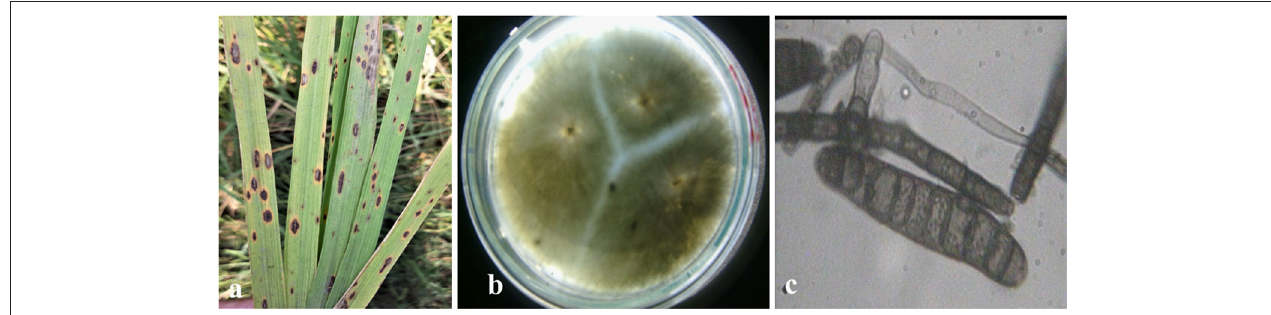
FIGURE 1 | Symptomology and microscopic identification of Bipolaris oryzae the causal organism of brown spot disease in rice. Typical lesions appeared as dark brown in color with grayish center and margins and typical yellow halo around the spot on rice leaves (a) . Isolation and purification of B. oryzae with gray to dark greenish septate mycelia observed on PDA media (b) . Microscopic observation showed dark brown to olivaceous brown conidia, curved or straight, fusiform with 6–16 transverse cell walls (c) .